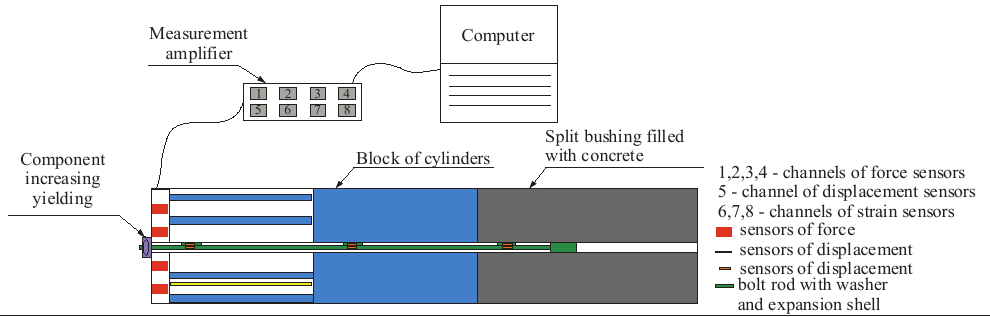
Fig. 3. Block diagram of the hydraulic system loading the rock bolt